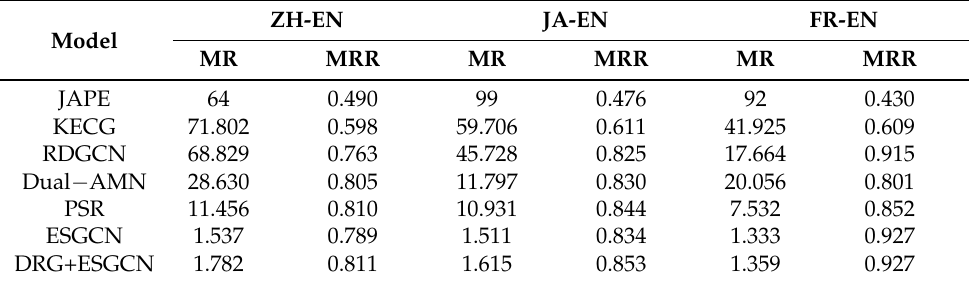
Table 3. Performance on DBP15K dataset